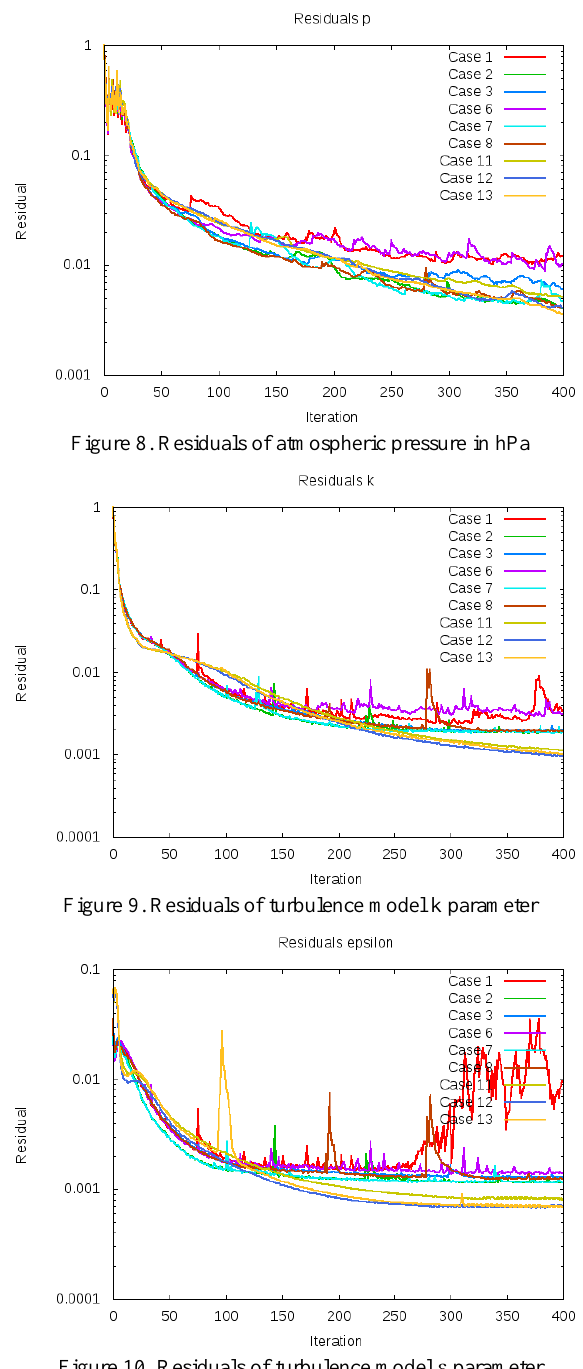
Figure 8. Residuals of atmospheric pressure in hPa